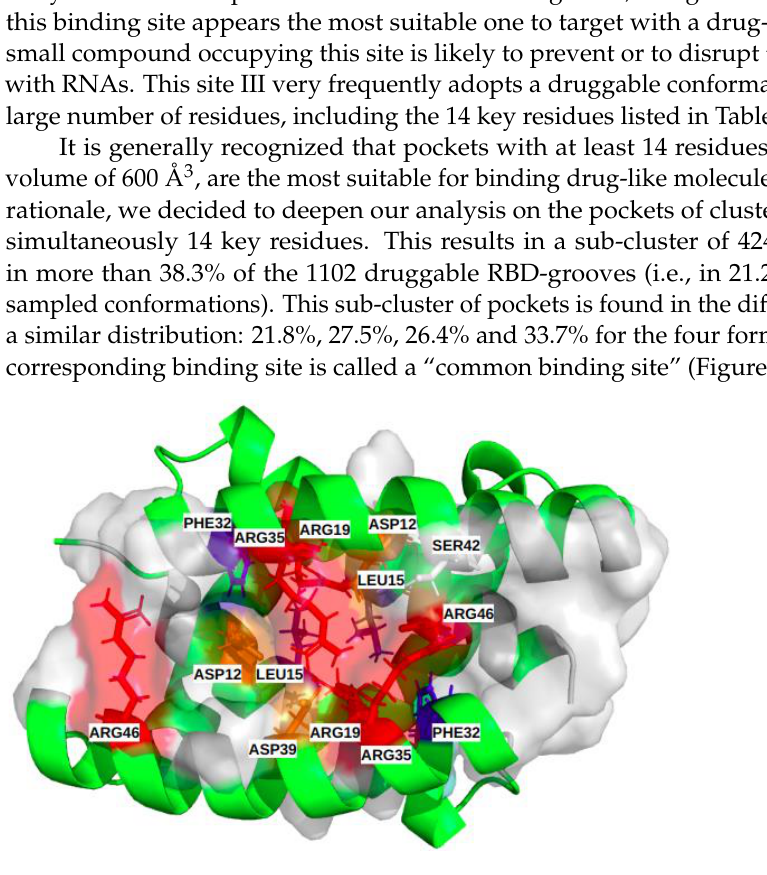
Figure 5. Illustration of the common binding site of the different subtypes, including the 14 most frequent residues (α [ASP12, LEU15, ARG19, PHE32, ARG35, ASP39, SER42); α’ [ASP12, LEU15, ARG19, PHE32, ARG35, ASP39, ARG46]). Physico-chemical properties of the corresponding residues colored red and orange for the positively and negatively charged ones, respectively, blue and slate-blue for the aromatic and aliphatic ones, respectively, and white for polar.